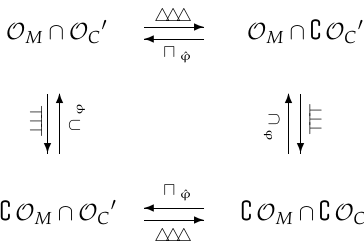
Figure 4. Four subspaces in